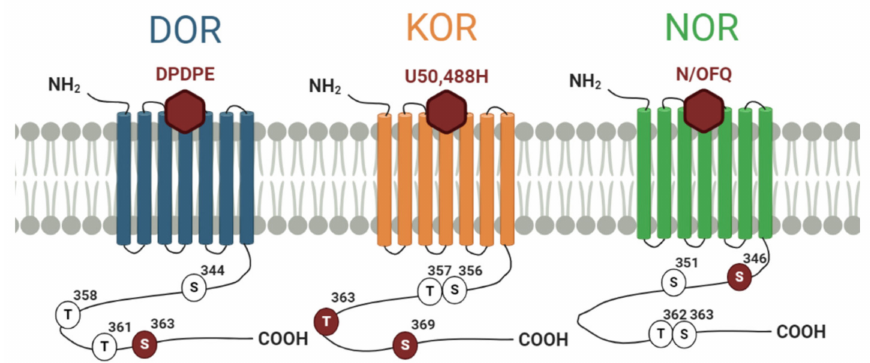
Figure 2. Phosphorylation sites for DOR, KOR and NOR. The primary phosphorylation sites are indicated in